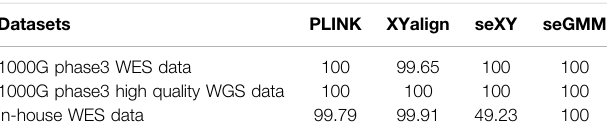
TABLE3| GenderpredictionaccuracyofdifferentmethodsfortheWESandWGS datasets. Datasets